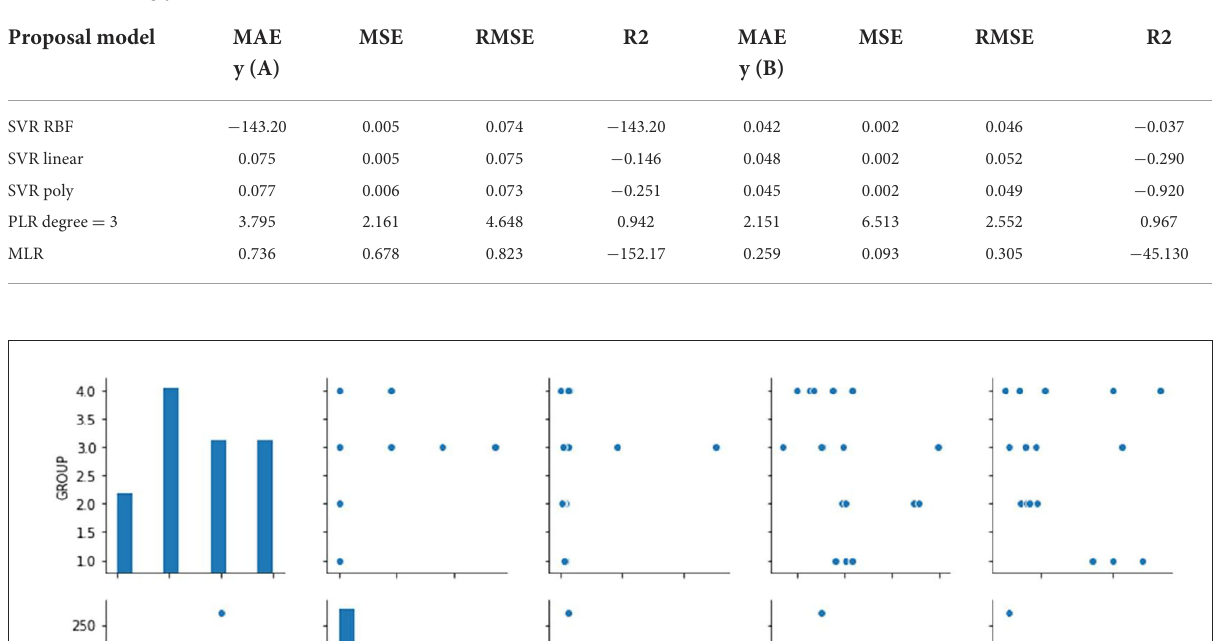
TABLE 6 Accuracy presentations of various models.